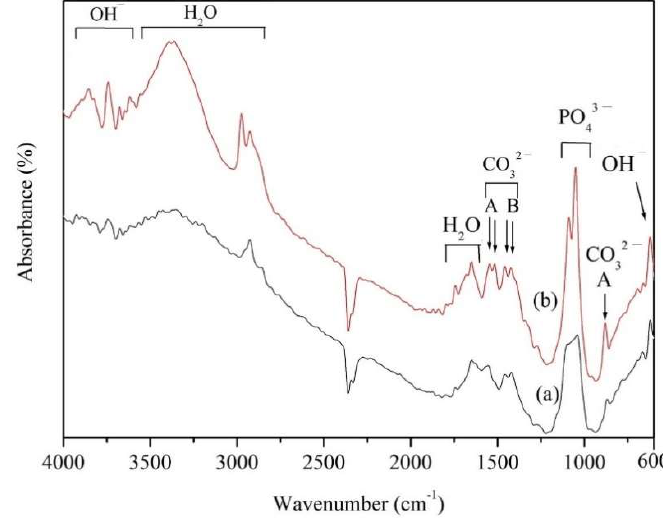
Figure 4. Fourier-transform infrared (FT-IR) spectra of HA-coated c.p. Ti samples after hydrothermal treatment at 150 °C for 48 h: non-heat-treated surface ( a ) and heat-treated surface at 500 °C for 2 h ( b ).